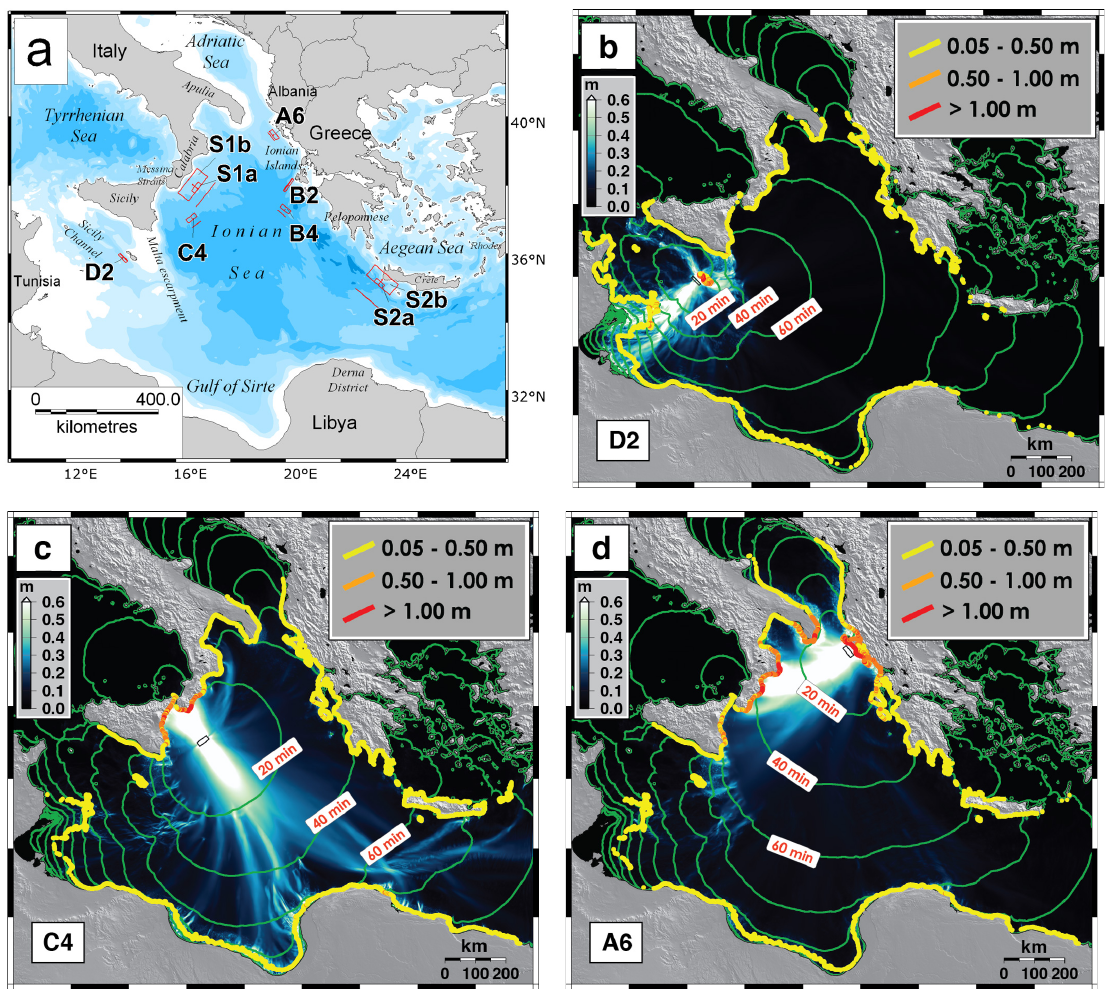
Fig. 6. Maps showing maximum wave heights ( H max ) and tsunami travel time (green contour lines at 20min intervals) for the exploration of the tsunamigenic potential of fault sources: (a) map of the individual sample ruptures (see fault parameters in Table 6); (b) Sicily–Tunisia Graben, crustal oblique-normal fault D2, M w = 7; (c) Calabrian Accretionary Wedge, crustal thrust fault C4, M w = 7; (d) Hellenides Fold- and-thrust Belt, crustal thrust fault A6, M w = 7; (e) Ionian Island Transform Fault Zone, crustal strike-slip fault B2, M w = 7; (f) Ionian Island Transform Fault Zone, crustal thrust fault B4, M w = 7; (g) Calabrian Arc, subduction interface S1a, M w = 7; (h) Hellenic Arc, subduction interface S2a, M w = 7; (i) Calabrian Arc, subduction interface S1b, M w = 8; (j) Hellenic Arc, subduction interface S2b, M w = 8. Yellow, orange and red dots indicate the H max values along the coasts lower than 0.5m, between 0.5 and 1m, and greater than 1m, respectively. Black rectangles represent the surface projection of the fault